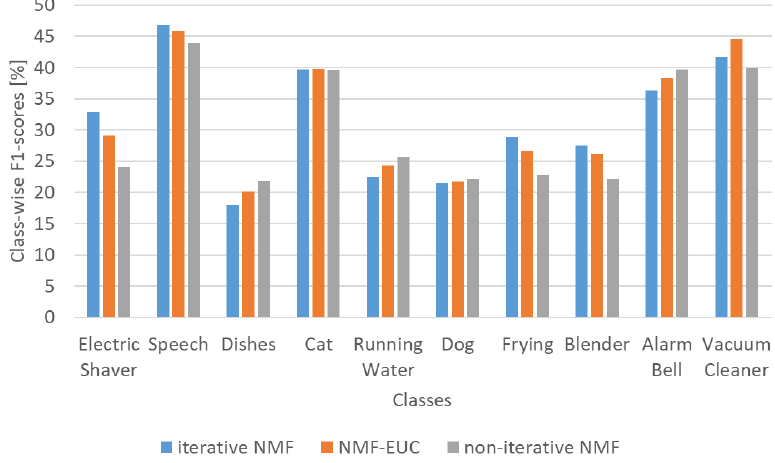
Figure 7. Performance comparison between the iterative NMF , NMF-EUC , and non-iterative NMF